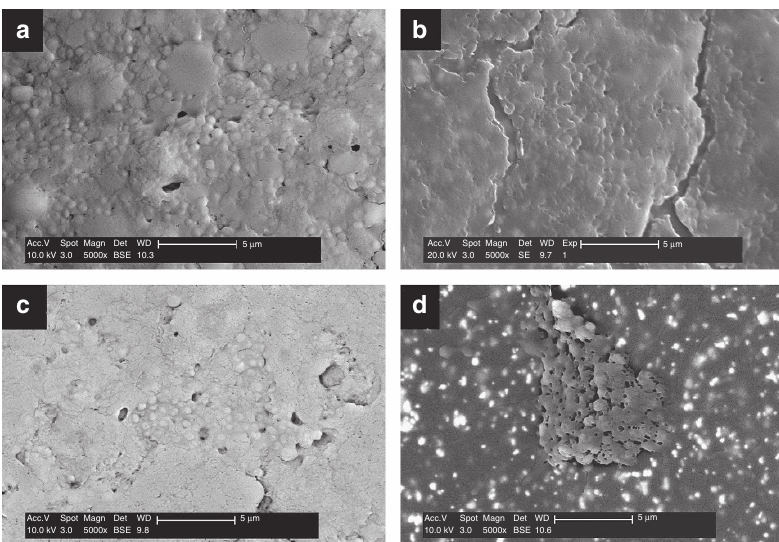
Figure 6 | Scanning electron microscopy images of S. aureus 2011S027 biofilms developed in vivo inside polyurethane catheters pieces. Fragments were retrieved from animals treated with sterile saline ( a ; control group), 4mgkg (cid:2) 1 caspofungin once daily ( b ), 40mgkg (cid:2) 1 moxifloxacin twice daily ( c ) or their combination ( d ). Scale bars, 5 m